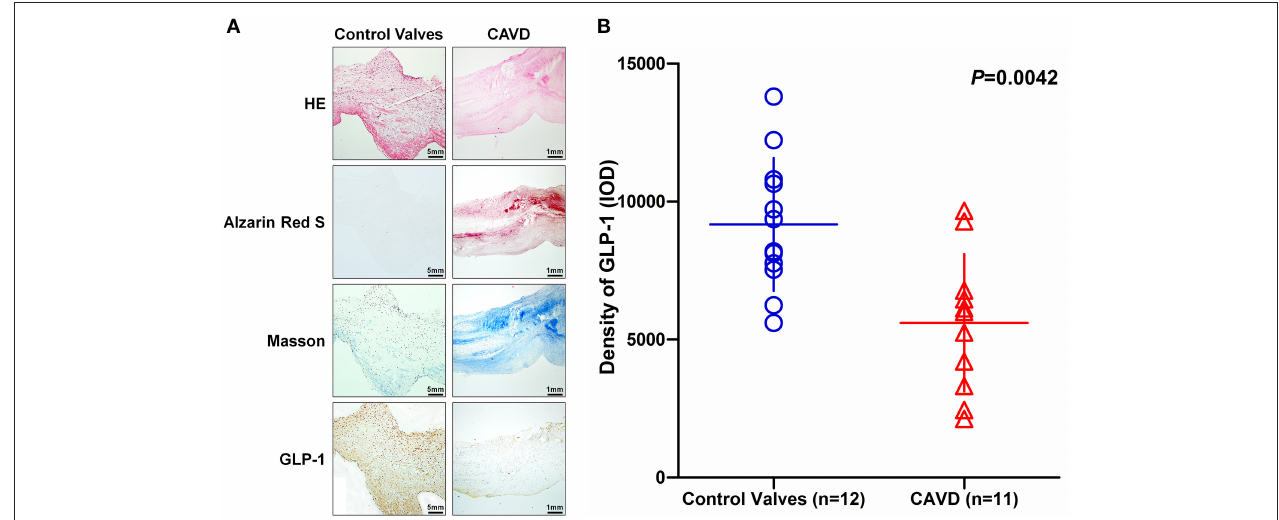
FIGURE 2 | The distribution of GLP-1 in aortic valves with or without calcification. Human aortic valves with calcification ( n = 11) that underwent valve replacement operation and without calcification ( n = 12) undergoing heart transplantation were assessed by histological and immunochemical analysis. (A) Sections were stained with hematoxylin and eosin, Alizarin Red S, and Masson trichrome staining. IHC stains of GLP-1 and counterstained with hematoxylin. The results of the Non-CAVD valves (left line) are shown at 100 × magnification, and the results of CAVD (right line) are shown at 20 × magnification. (B) The concentration of GLP-1 detected by IHC was determined by assessing its staining with Image-Pro Plus 6.0. The results are shown as the integrated optical density (IOD)/area. The Non-CAVD ( n = 12) and CAVD valves ( n = 11) are representative of three independent experiments, and five different fields in each section were detected (the P -value was control valves compared with